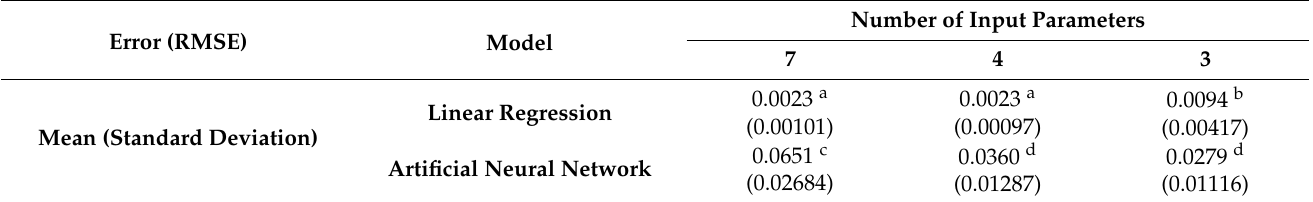
Table 3. The error between the values predicted by the model and those measured for the three models.